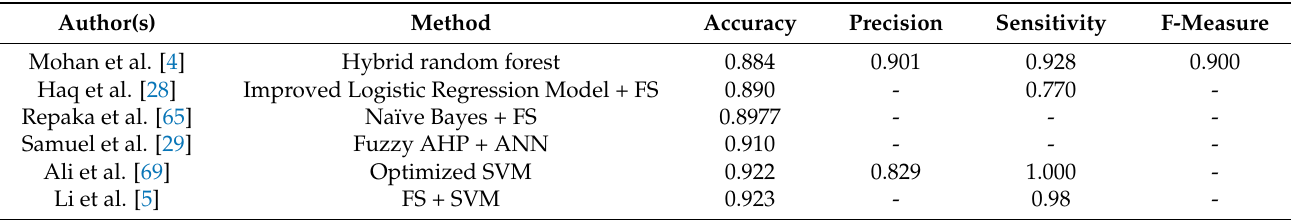
Figure 5. ROC curve of the classifiers using the CKD dataset. Table 7. Performance comparison with other heart disease